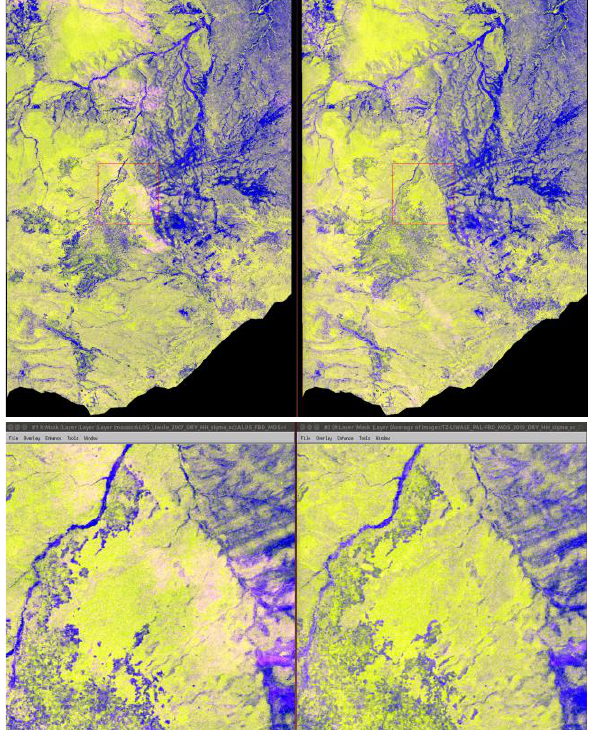
Figure 6. (Left) forest/woodland mask from classifying the maximum HH and HV backscatter mosaics. (Right) 2007-2010 forest and woodland loss in red and orange,